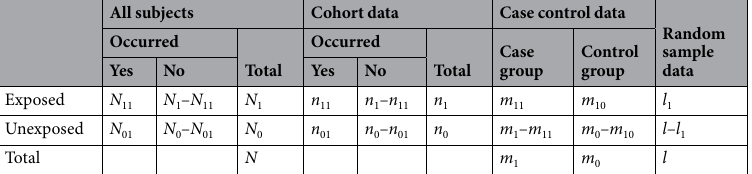
Table 1. Contingency tables for all subjects, cohort, case control, and random sample data. “Subjects”( N ) comprise “Exposed”( N 1 ) and “Unexposed”( N 0 ), both of which include subjects for whom an event occurred ( N 11 and N 01 ). Both of exposed and unexposed cohort ( n 1 and n 0 ) have subjects for whom the event occurred ( n 11 and n 01 ). Exposed subjects ( m 11 and m 10 ) can be found in both of case and control group ( m 1 and m 0 ). Exposed subjects (